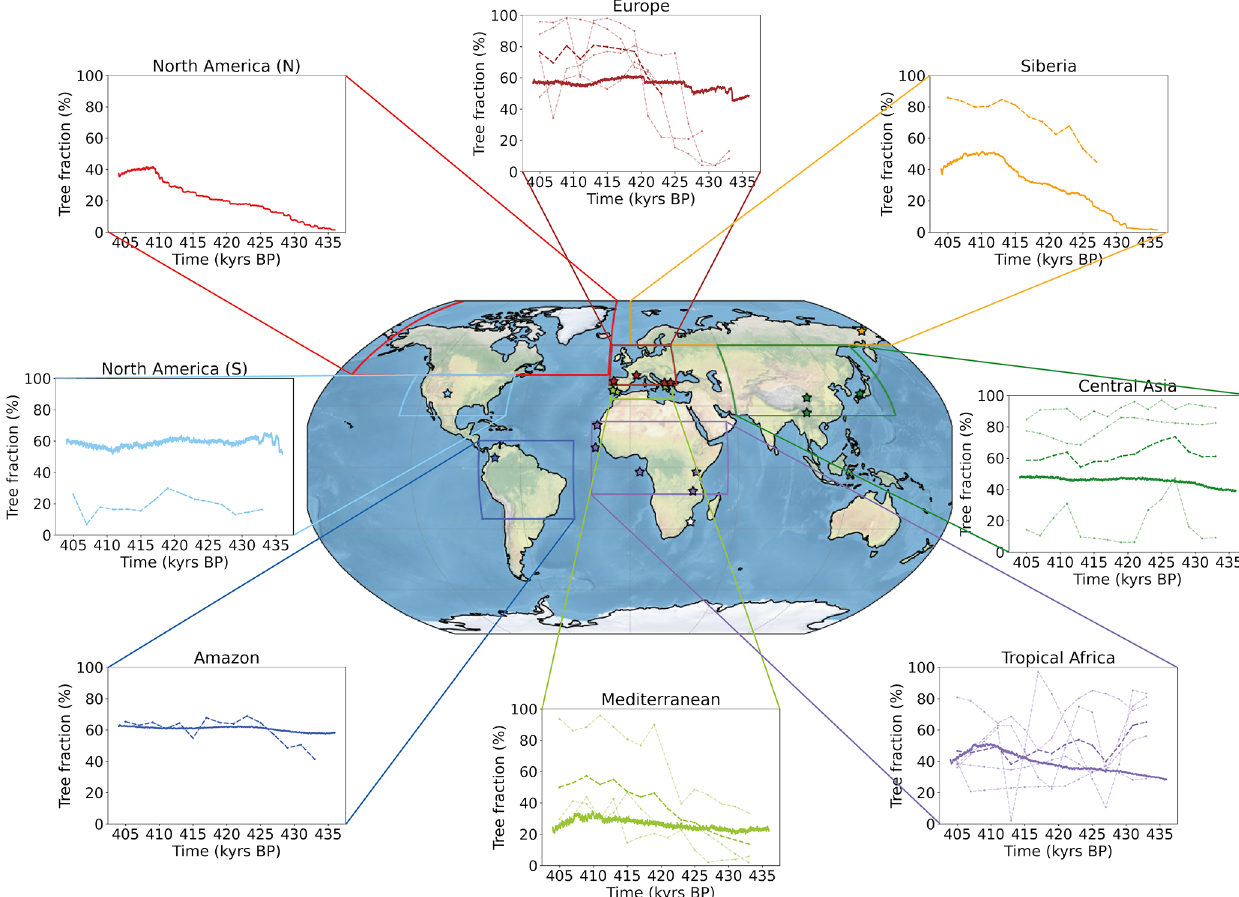
Figure 7. Comparison of simulated tree fraction and forest pollen percentage by region across TV. Each plot shows the simulated tree fraction average (%, solid line) over the corresponding regional box (coloured contours) and associated forest pollen record (%, pale dotted line) and record average (%, bold dotted line) when available. Locations of pollen records are marked by coloured